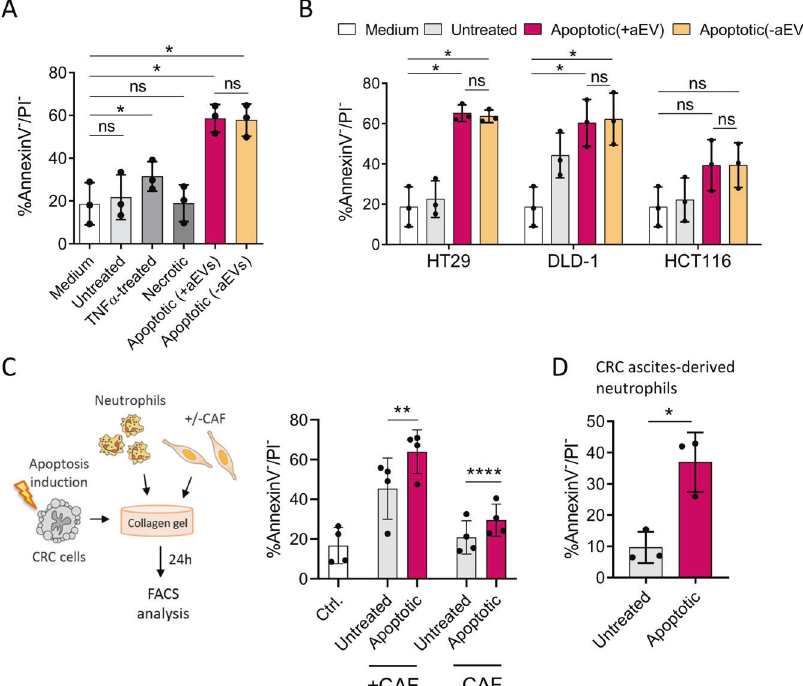
Fig. 2 Apoptotic-tumour cell-derived factors prolong neutrophil lifespan. A , B Survival of healthy donor-derived neutrophils stimulated for 24 h with culture medium (negative control), conditioned media (CM) of untreated, TNF α -treated, necrotic or apoptotic A CG08, B HT29, DLD- 1, or HCT116 cells. Neutrophil viability was determined by annexin V/propidium iodide (PI) fl ow cytometry staining ( n = 3). Where indicated, apoptotic cell-derived extracellular vesicles (aEVs) were depleted from apoptotic CG08 CM using sequential centrifugation steps at 450 × g , 7000 × g , and 92,000 × g (CM -aEVs). C Survival of healthy donor-derived neutrophils in 3D CRC models. Neutrophil viability was determined by annexin V/PI staining following 24 h of co-culture with apoptotic or untreated CG08 CRC cells and cancer-associated fi broblasts (CAFs) within a collagen I matrix. Neutrophils cultured in collagen I gels in the absence of tumour cells and CAFs served as control ( n = 4). D Survival of neutrophils isolated from malignant ascites of CRC patients, after 24 h stimulation with CM of untreated or apoptotic CG08 CRC cells ( n =